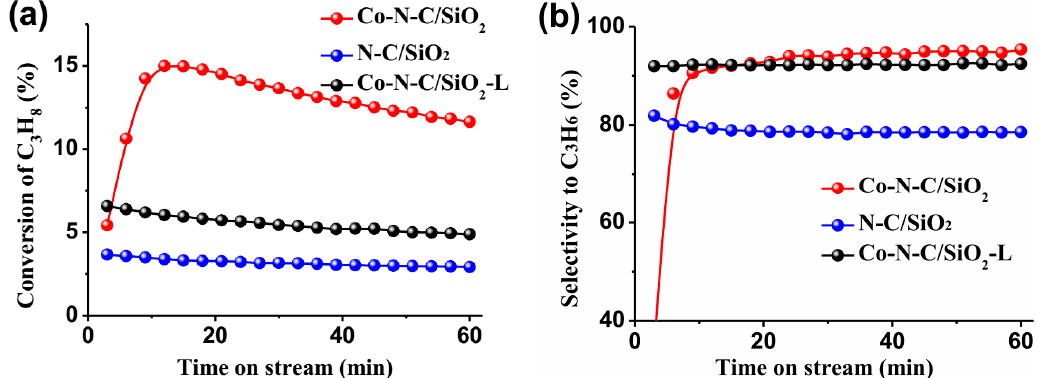
Figure 5. Propane conversion ( a ) and selectivity to propylene ( b ) as functions of time on stream over Co-N-C/SiO 2 , Co-N-C/SiO 2 -L and N-C/SiO 2 catalysts at T = 600 °C and P = 1 atm. Gas mixture: 10 vol% propane, N 2 balance; GHSV = 7500 mL h − 1 g cat − 1 .